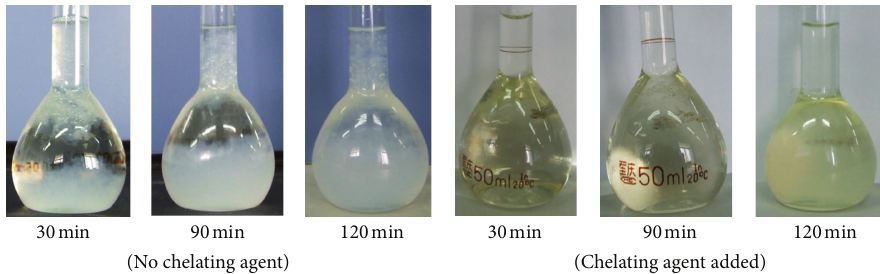
Figure 12: Comparison of chelating agent added before and after in Si ion standard solution.